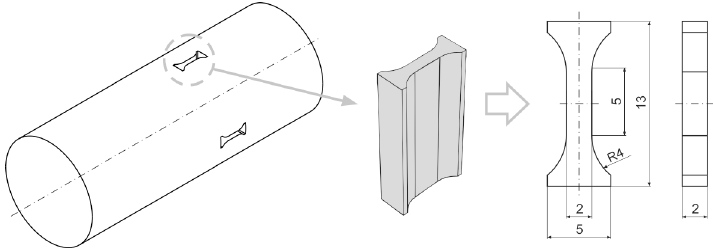
Figure 1. Schematic representation of sample extraction for tensile testing. Flat miniature tensile specimens were cut from the extruded material using wire electric discharge machining.